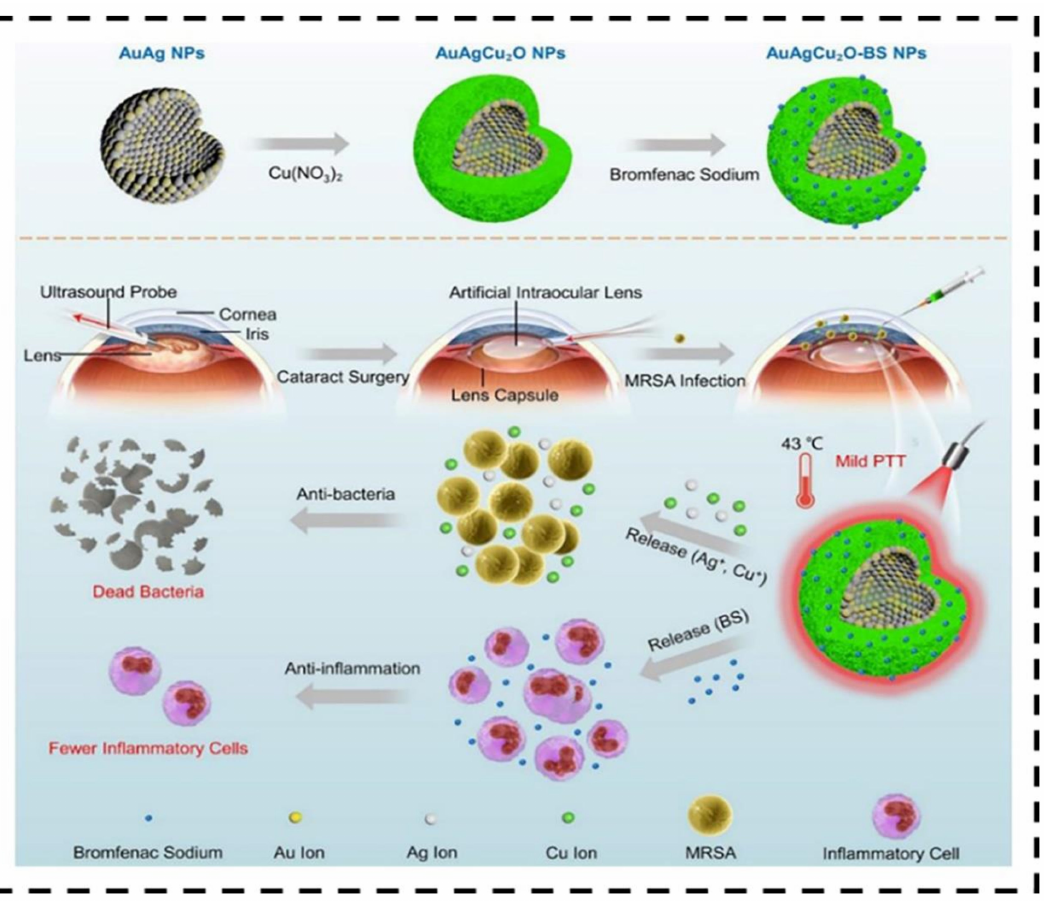
Figure 6. The illustration shows the treatment of AuAgCu 2 O-BS NPs to the endophthalmitis after cataract surgery. Adapted with permission from Ref. [106]. 2020, Ivyspring International